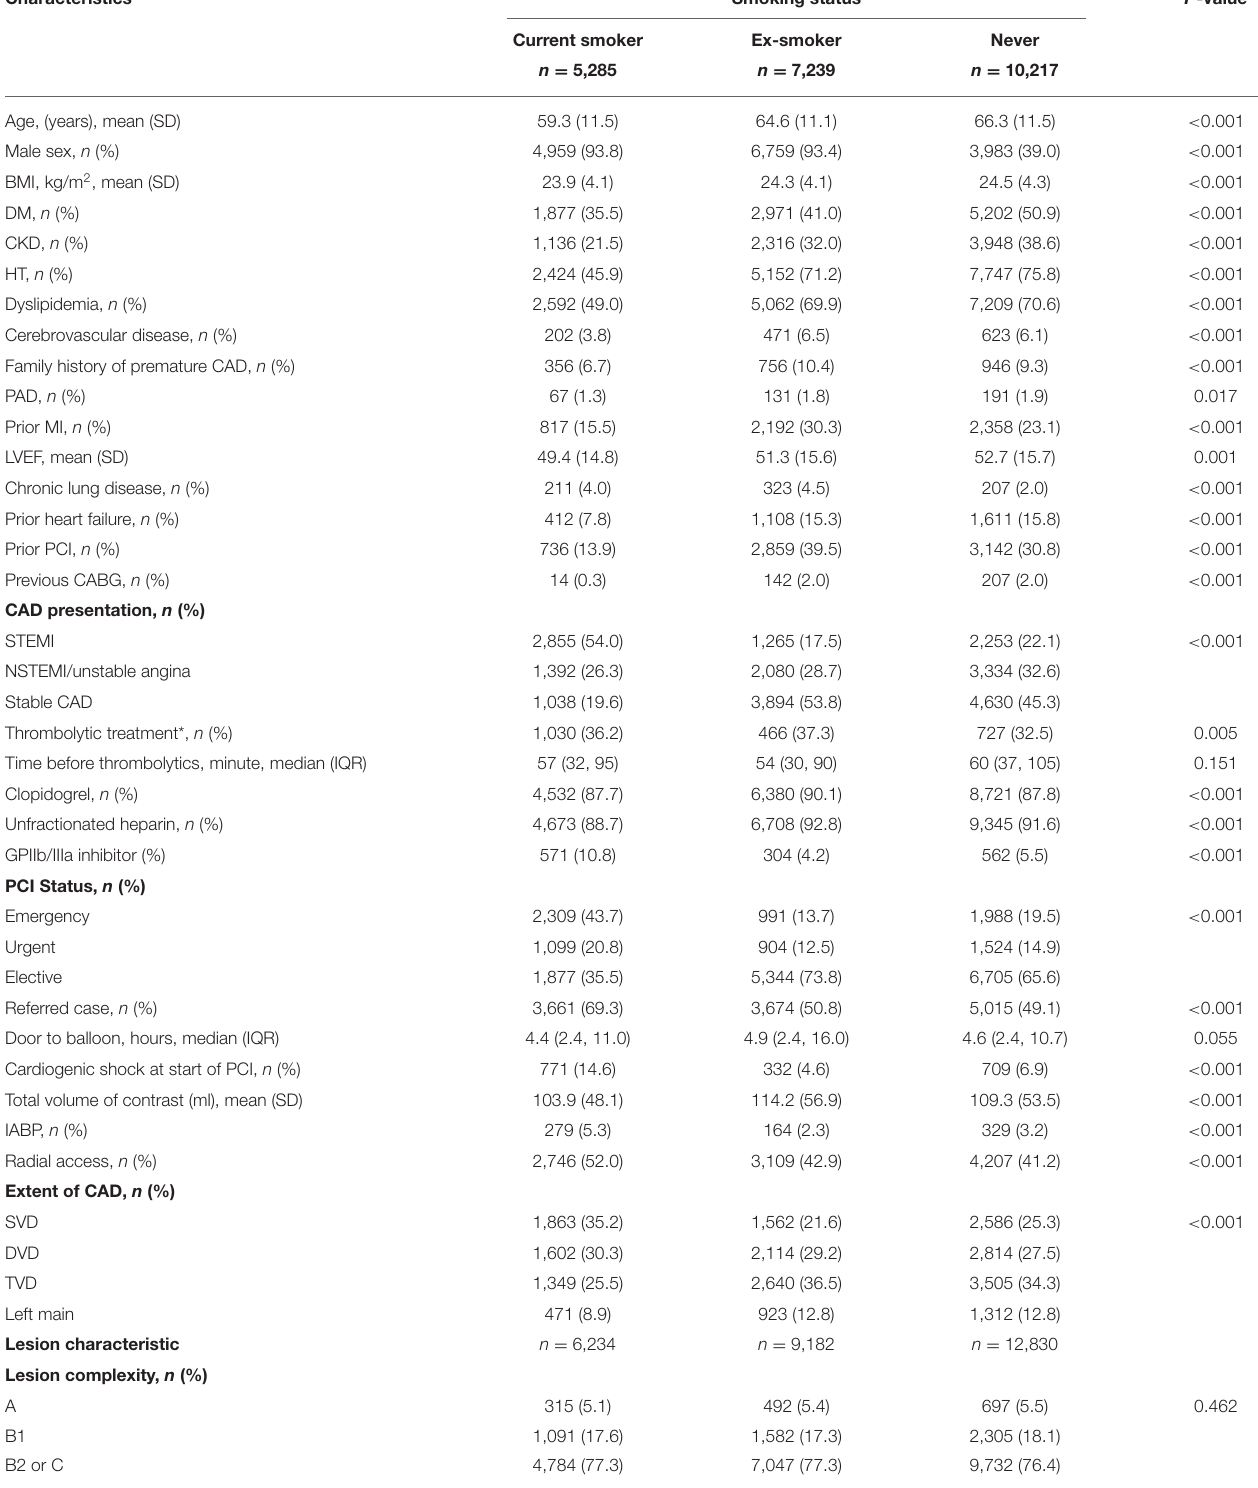
TABLE 1 | Baseline clinical and angiographic characteristics of 22,741 patients undergoing PCI, grouped by smoking status.